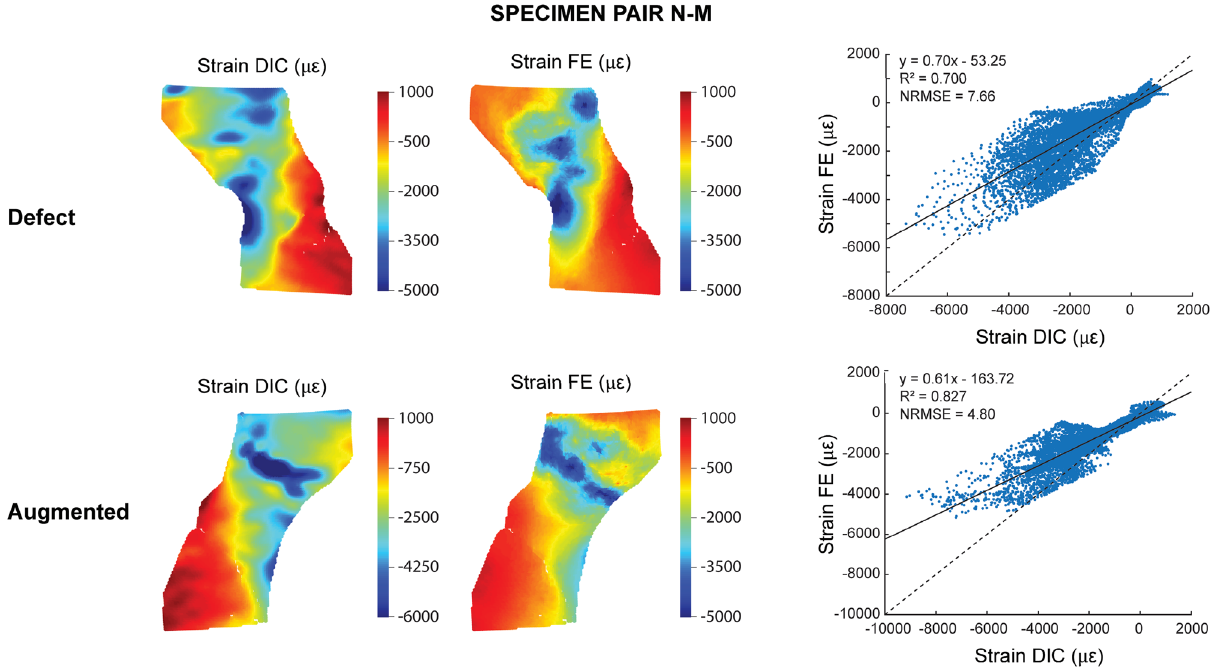
Figure 5. Validation strains. (Left) Qualitative comparison of the nominal DIC and FE strains at the anterior surface of the proximal femur. The results are displayed for a representative specimen pair (N–M) at 75% peak experimental force. Note that the scales for the FE and DIC measurements were not matched to allow a better visual comparison of the relative distribution. (Right) Quantitative comparison of the strain values through linear regression analysis.